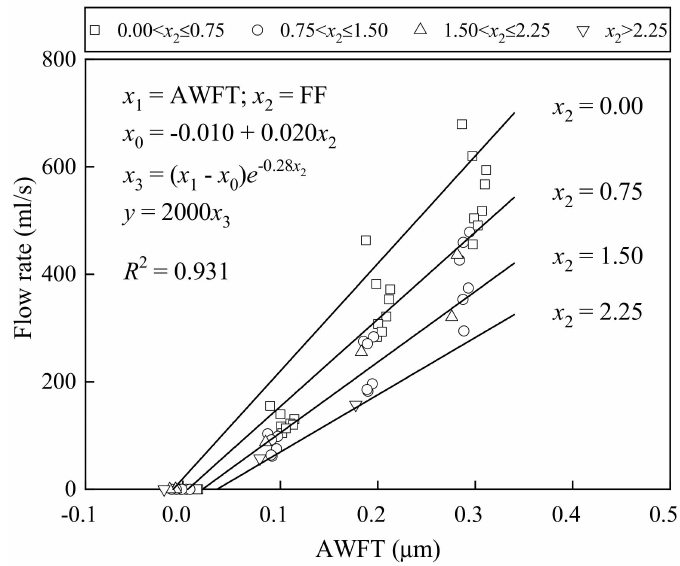
Figure 7. Correlation of flow rate with AWFT and